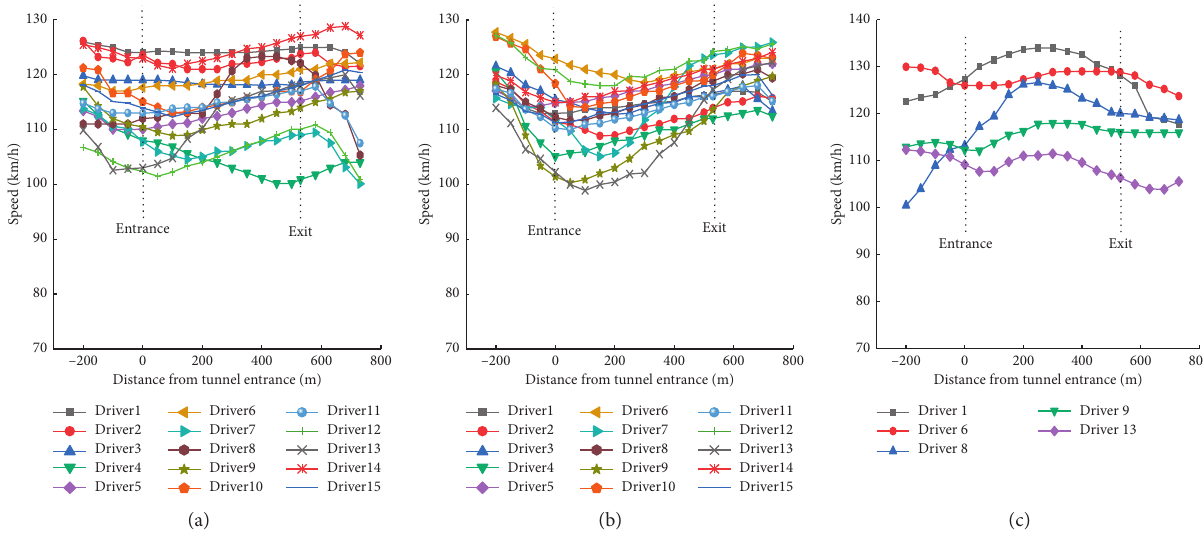
Figure 5: Operating speed change between different right lateral clearance schemes. (a) Scheme 1. (b) Scheme 2. (c) Scheme